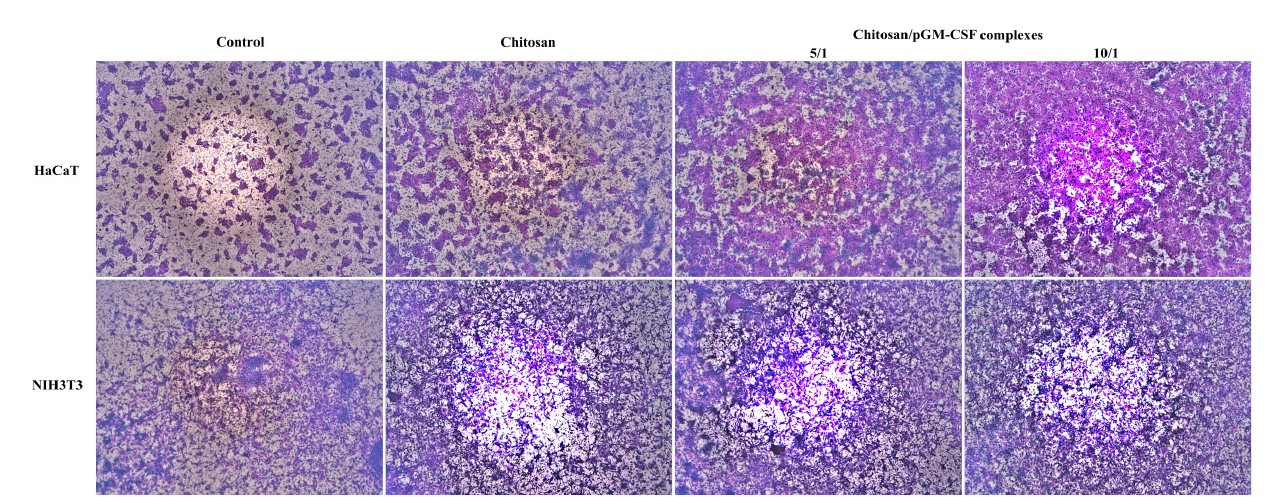
FIGURE 5 - In vitro migration assay in HaCaT and NIH3T3 cell